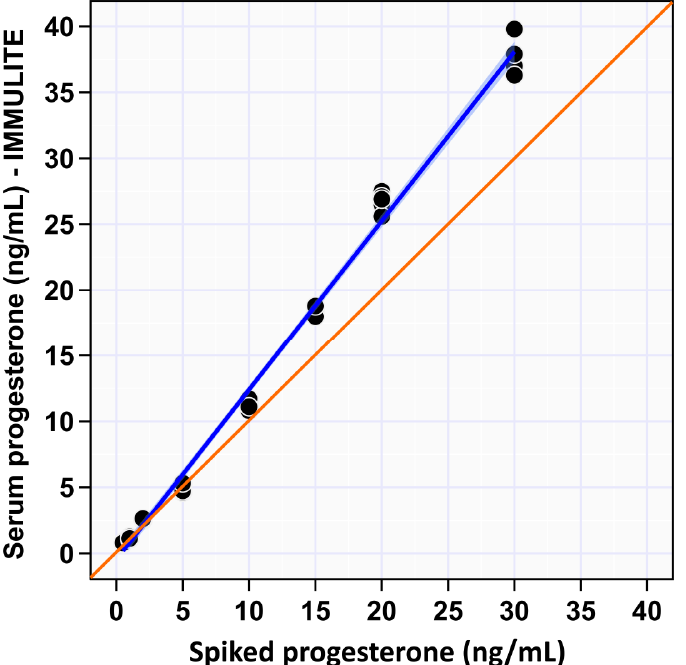
Figure 1. Scatter plot showing linearity of reportable range of spiked serum P4 concentration measured by IMMULITE ® 2000 XPi immunoassay (Siemens, Cary, NC, USA). The orange line is identity line, and the blue line is the regression line. Regression line equation calculated in Excel: True P4 = −0.44 + 1.28x.